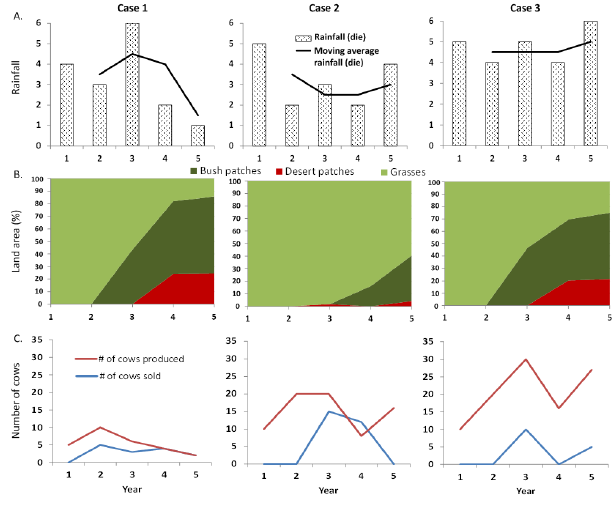
Fig. 7 . Grazing game trial results in Ghana with rainfall patterns reflecting dry conditions with decreasing rainfall (case 1), dry conditions with increasing rainfall (case 2), and wet conditions with increasing rainfall (case 3): (A) pattern of average rainfall, (B) land-use trajectories, and (C) yields from cow production.